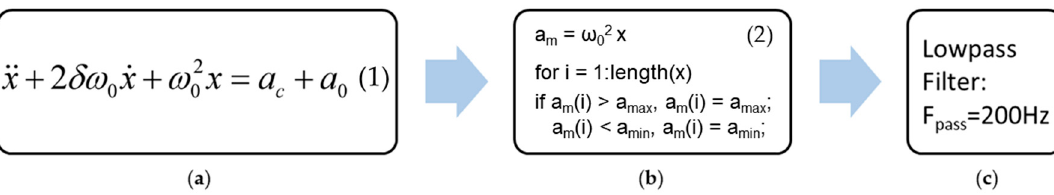
Figure 4. The three steps of the mathematical model: ( a ) An equation used to calculate the output value. ( b ) The output with bilateral asymmetric clips. ( c ) A low-pass filter.